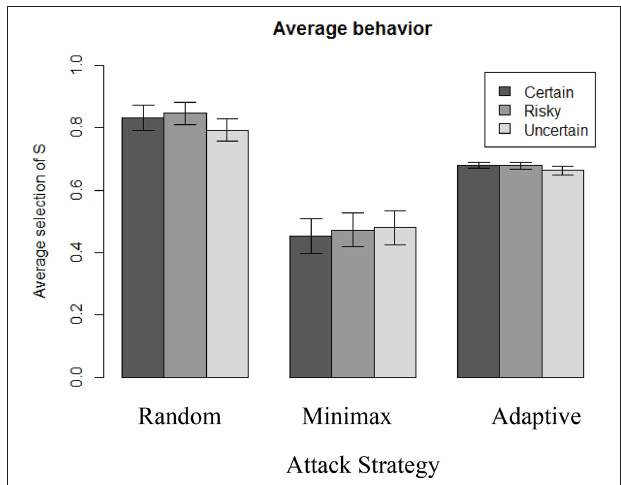
FIGURE 5 | Average selection of S action in each condition.